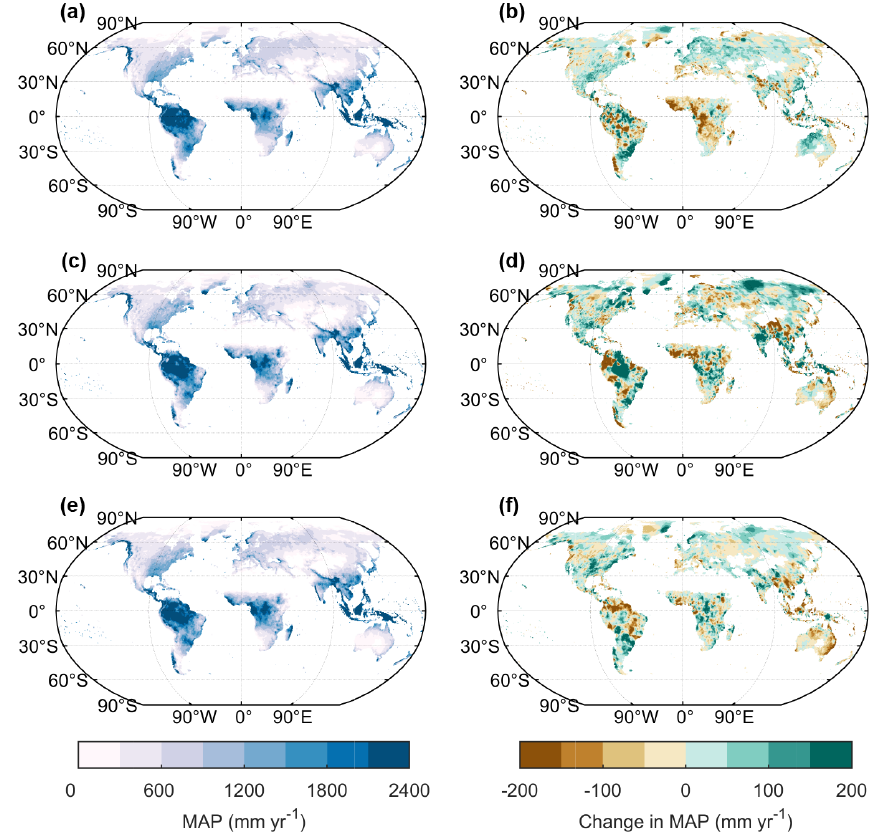
Figure 4. Spatial pattern of MAP and changes in MAP. (a) The MAP in 1987–2016 from GSWP3. (b) The spatial pattern of change in MAP between the period of 1951–1980 and 1987–2016 from GSWP3. (c, d) Same as (a) and (b) but for the emulation from simple linear. (e, f) Same as (a) and (b) but for the emulation from PREMU.